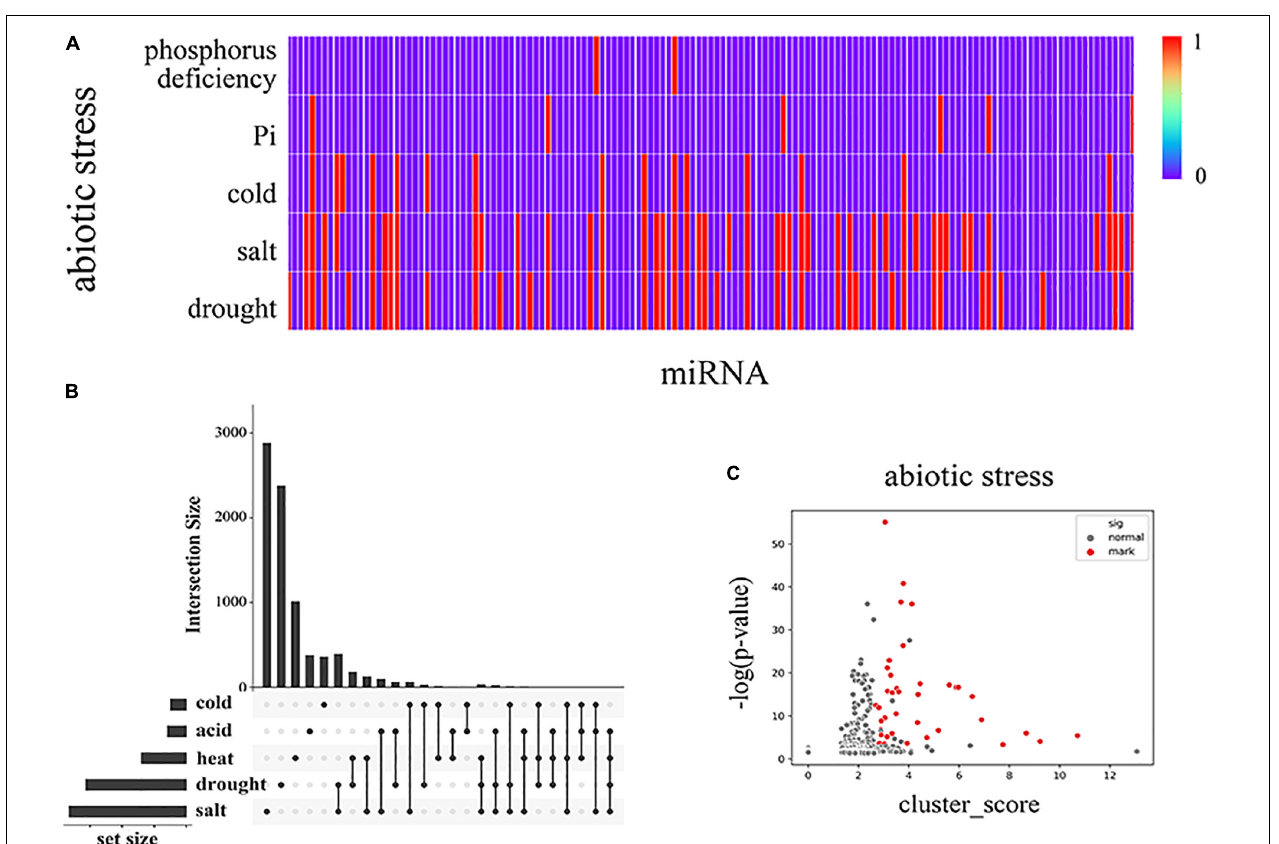
FIGURE 6 | Collected miRNA data on soybeans involved in various abiotic stress responses based on the data statistics from the literature. (A) The distribution of stress types in miRNAs where each vertical line represents one miRNA, and red is marked as relevant, (B) UpSet diagram (Lex et al., 2014) of modular genes under various abiotic stresses within the horizontal correspondence, where dots are used to refer to the corresponding cold stress, acid stress, heat stress, drought stress, and salt stress on the left. The point-to-point connection is realized longitudinally to indicate the intersection between the corresponding data sets, and the upper bar graph shows the number of genes in the intersection. In panel (C) , the differentially expressed genes in each MTRM under abiotic stress are shown after screening. We used three indicators to filter the candidate clusters. According to the p -value, the related miRNA purity and the cluster score of each MTRM gene are placed under the corresponding stress. We selected the corresponding threshold, obtained the stress-related MTRMs with higher reliability, and marked them as red dots in Panel (C) . Supplementary Figure 2 shows MTRMs under other types of